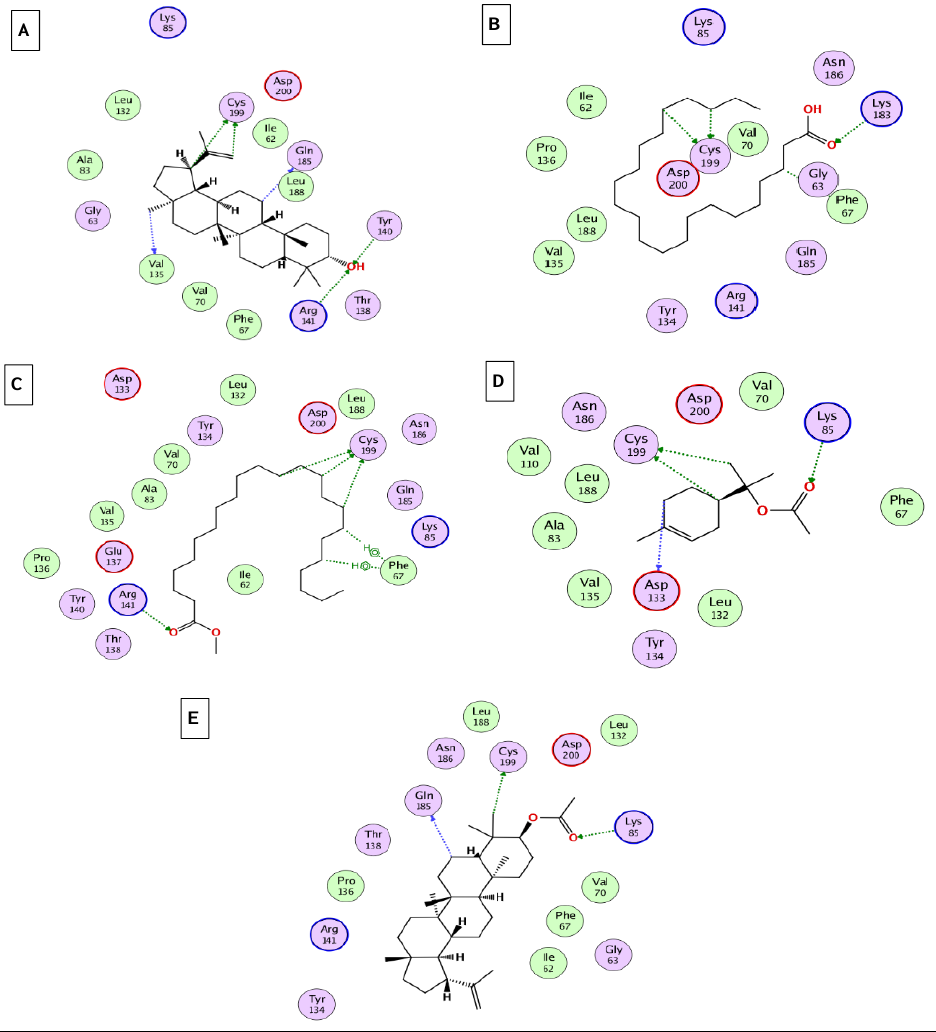
Figure 7. 2D binding modes of lupeol ( A ), n- docosanoic acid ( B ), methyl tricosanoate ( C ), α -terpinyl acetate ( D ), and lupeol acetate ( E ) to the active binding sites of glycogen synthase kinase 3- β (GSK3- β).